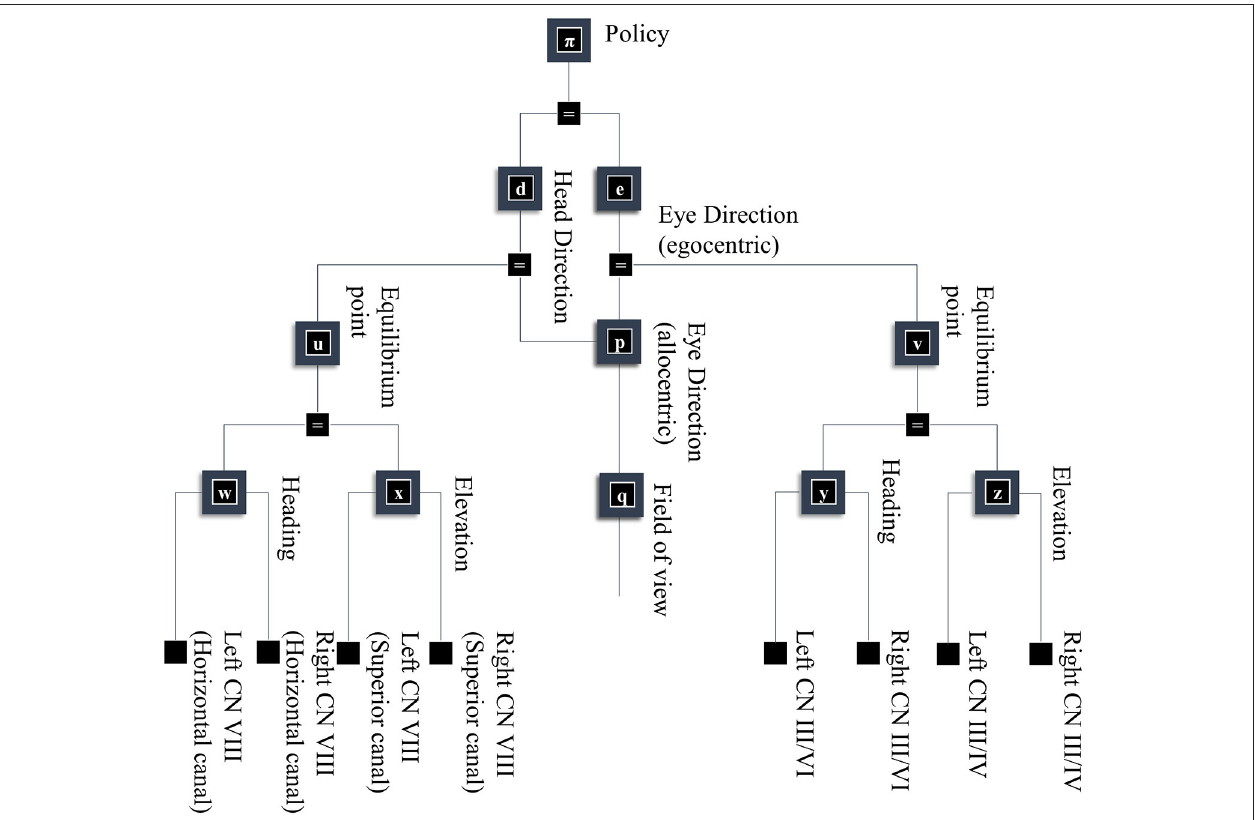
FIGURE 5 | A generative model for looking. This figure builds upon part of the model shown in Figure 1 . Specifically, it unpacks some of the other sources of data resulting from the eye and head-direction factors and includes a policy variable that determines priors over these variables. These depend upon dynamical systems. This means predicting an equilibrium point (or attractor) that the eyes or head are drawn toward. These dynamics may be divided into changes in the elevation or heading angles. For head movements, the velocity of the head causes changes in the semi-circular canals in the inner ear, communicated to the brain by cranial nerve (CN) VIII. For eye movements, the position and velocity of the eyes give rise to proprioceptive signals due to stretch of the oculomotor muscle tendons, communicated to the brain by CN III, IV, and